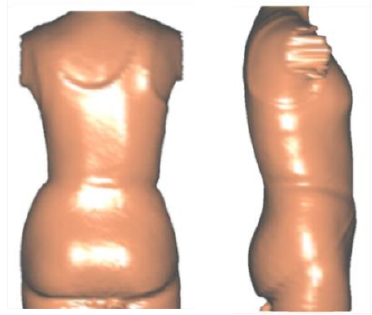
Figure 4. CAD model of a Boston Brace 3D orthosis.